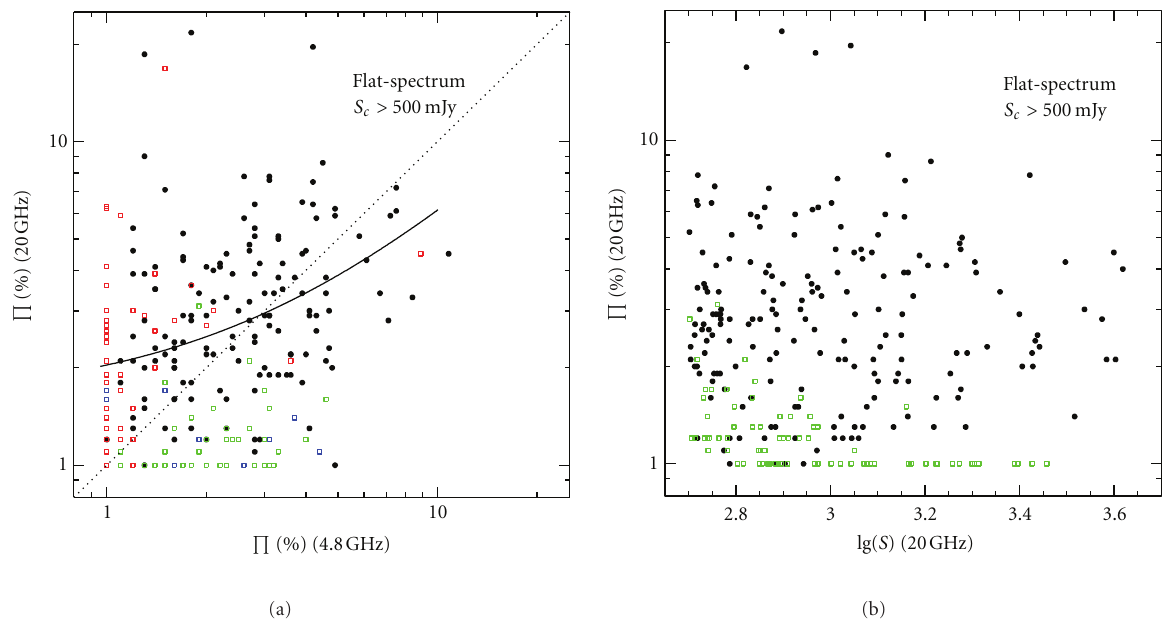
Figure 3: (a) Correlation between fractional polarizations at 4.8 and 20 GHz for flat-spectrum sources with S ≥ 500mJy. Green points indicate upper limits in Π at 20GHz, red points at 4.8 GHz, and blue points at the both frequencies. The solid line is the linear regressions found by the ASURV code (see the text). (b) The fractional polarization at 20GHz as a function of the flux density at the same frequency (green points indicate upper limits in Π